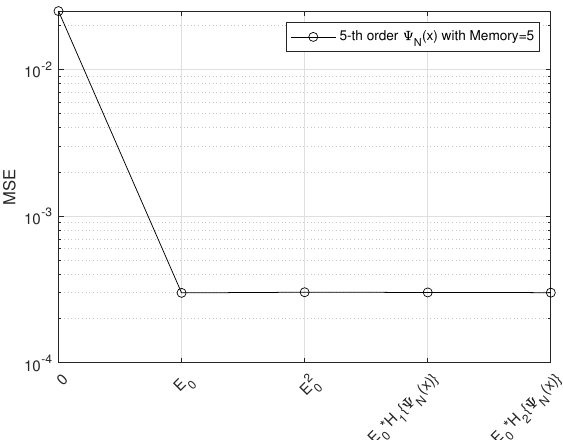
Figure 6. MSE dependence on the order of the E 0 input, where some cross-terms are also included. The error after the linear order is not decreasing, which indicates that the system only depends on E 0